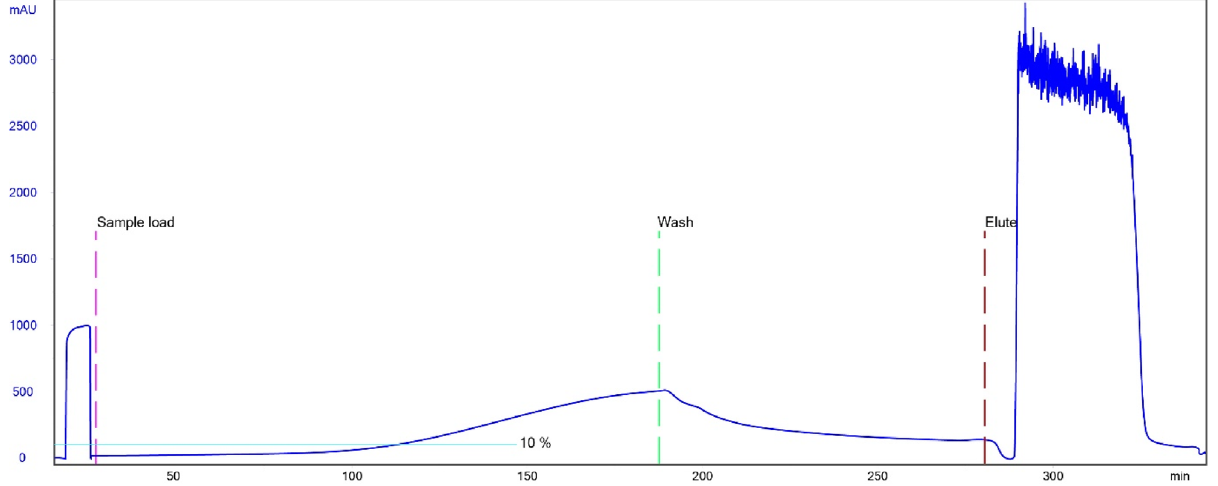
Figure 5. Chromatogram of DBC determination for peptide A 1 mL affinity